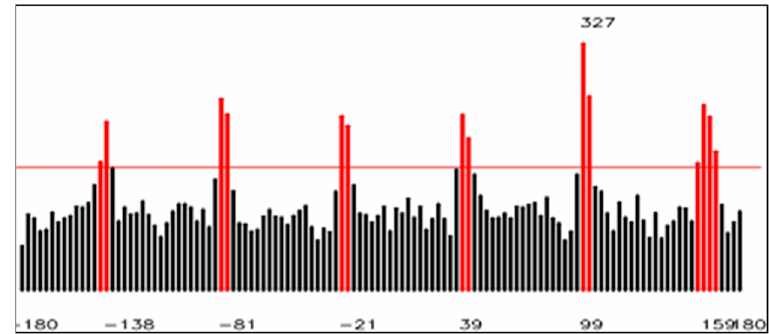
Figure 4. Using gradient direction to find out the six